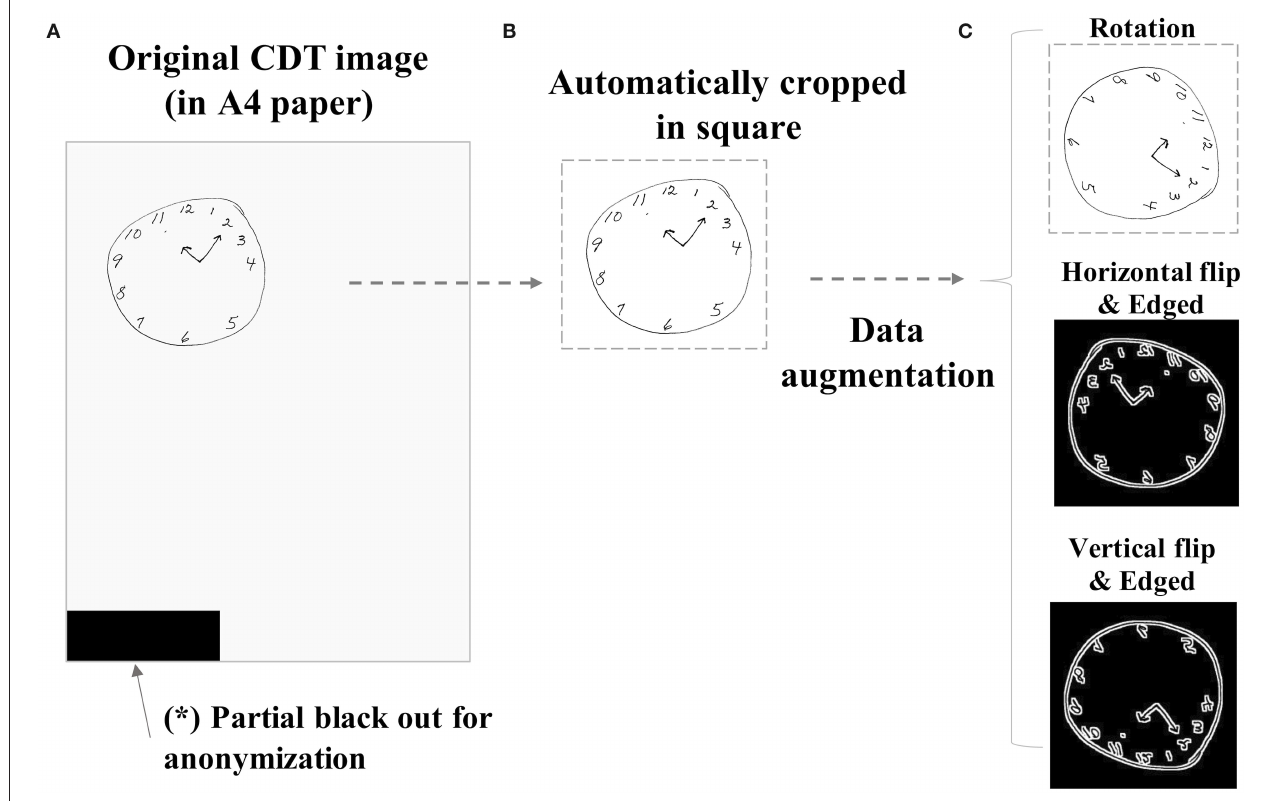
FIGURE 1 | Sample image preprocessing procedure. The original CDT images drawn on A4-sized papers (A) were preprocessed by automatically cropping in a square (B) . The images were further augmented by several combinations of manipulations such as rotation (90 or 180 ◦ ), horizontal flip, vertical flip, or black–white reversal by edging (C) . CDT, Clock-Drawing